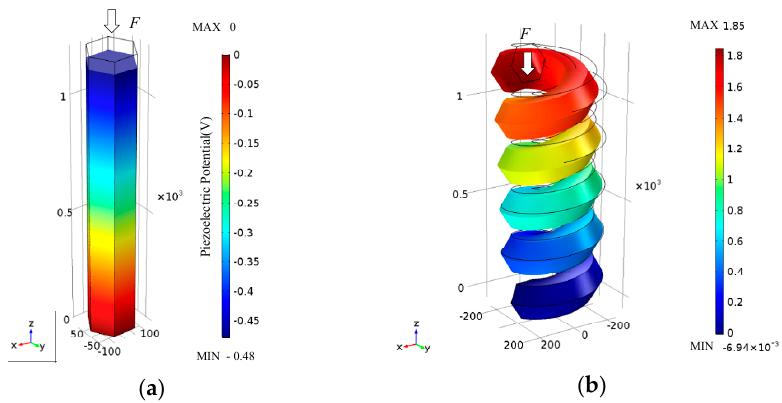
Figure 2. The piezoelectric potential distribution in ( a ) ZnO nanowire and ( b ) nanohelix under a compressing force of 100 nN along the z -axis. compressing force of 100 nN along the z